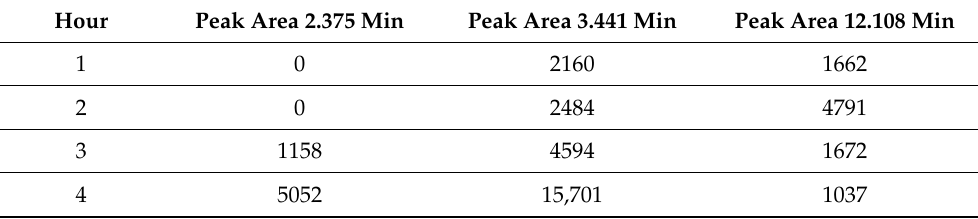
Table 1. Peak areas of TurmiZn from Figure 5B in plasma from oral administration over 4 h. Hour Peak Area 2.375